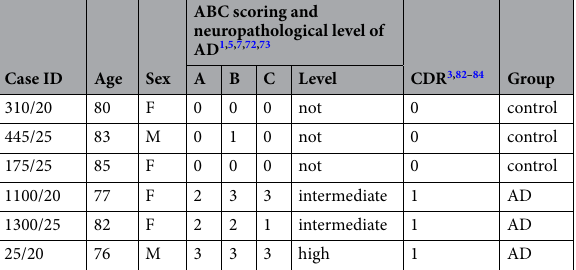
Table 5. Cases used in the study. CDR: Clinical Dementia Rating. F: Female. M: Male. AD: Alzheimer’s